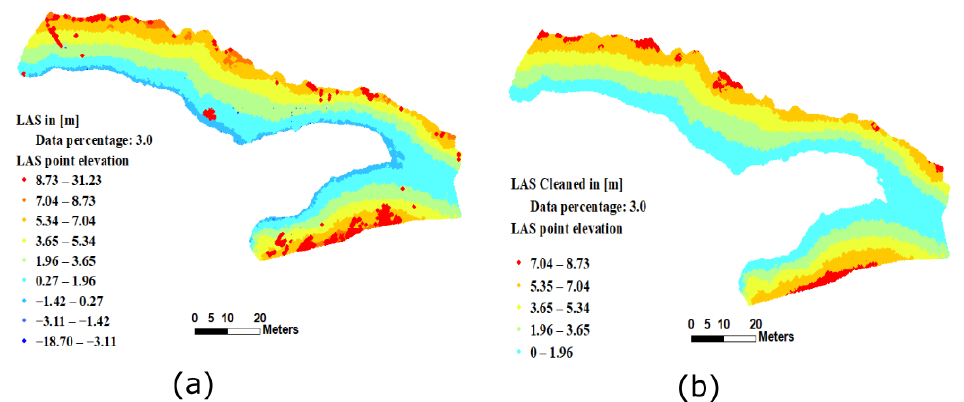
Figure 8. DSM of the emerged zone. In ( a ), outliers are represented in red color close to the outer boundary of the study area, while ( b ) represents the emerged zone after filtering and cleaning noises to obtain a more reliable elevation range starting from the shoreline, thus obtaining a DSM ranging from zero to 8.75